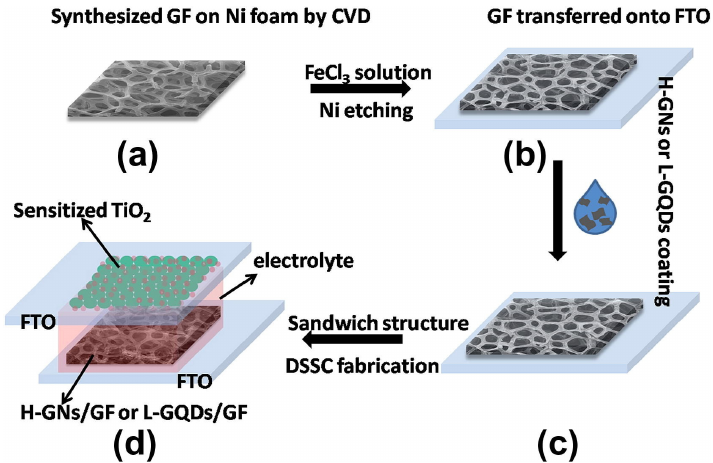
Figure 16. Schematic presentation of a reduced graphene oxide-GF hybrid CE integration in DSSC. ( a ) Template-assisted CVD growth; ( b ) free-standing GF transfer on FTO; ( c ) GF/FTO coating with reduced graphene-based solution (H-GN: heat reduced graphene nanosheets, L-GN: laser reduced graphene nanosheets); ( d ) DSSC configuration. Reprinted from ref. [79] with permission from Elsevier.